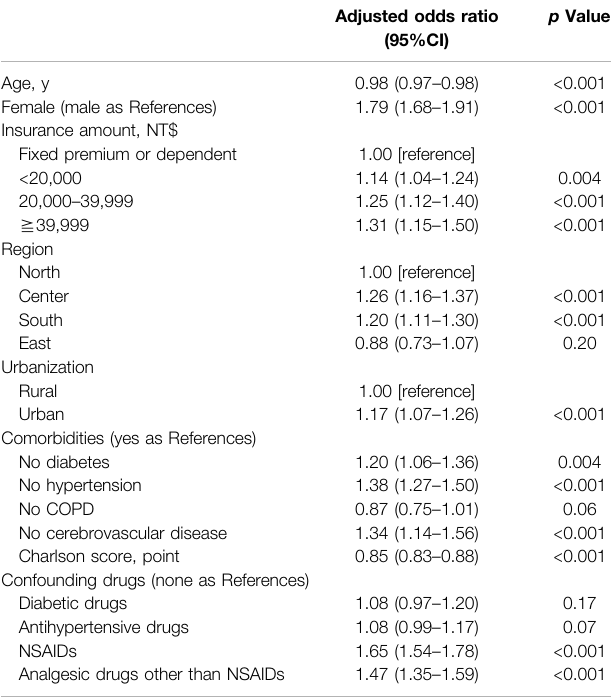
TABLE 3 | Factors associated with harmonizing formula prescription in patients with chronic kidney